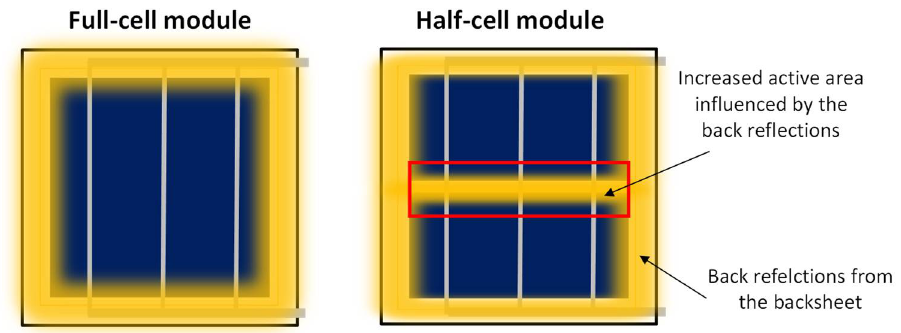
Figure 2. Schematic view of the area influenced by the back reflections of light rays from the backsheet over on the edges of the solar cells in both ( left ) full-cell and ( right ) half-cell layouts. To compare the influence of the design transition from full-cell to half-cell, two PV